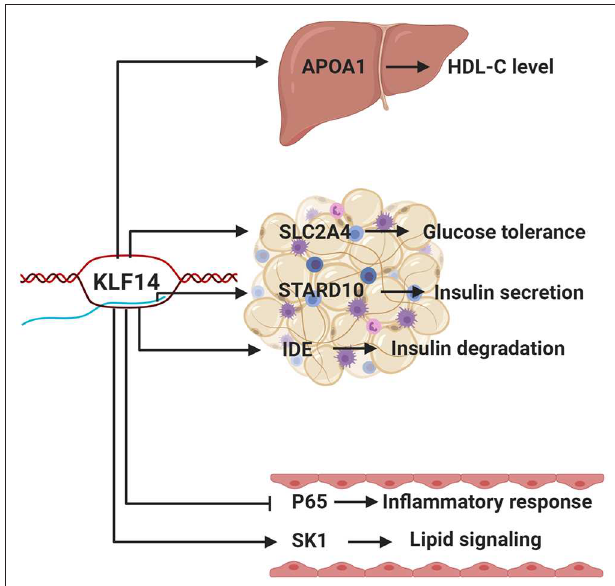
FIGURE 2 | The function of KLF14 in metabolic tissues. Putative KLF14 transcription targets in different metabolically active tissues/organs, as well as their potential roles, are shown. Human genetics studies show that risk allele is associated with lower KLF14 expression in adipose tissue. Schematic depicts the KLF14 risk